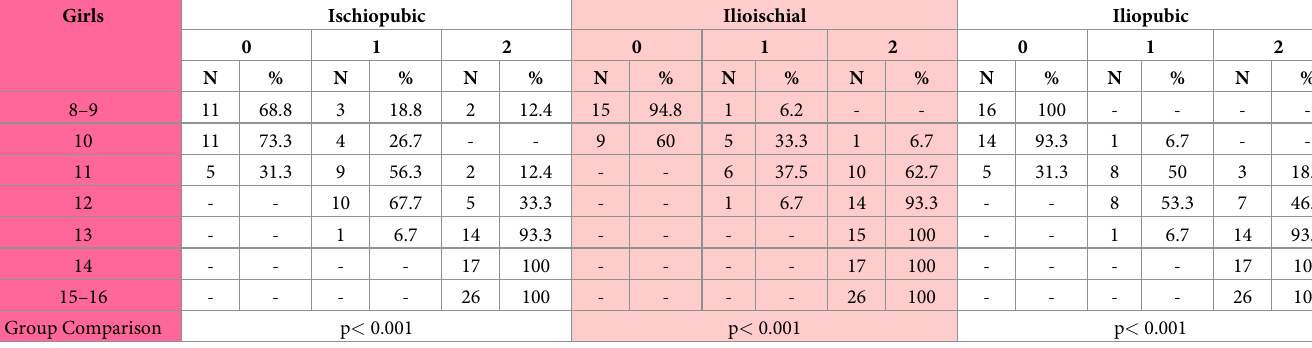
Table 1. Ischiopubic, ilioischial, and iliopubic synchondrosis junction points in girls by age. Girls